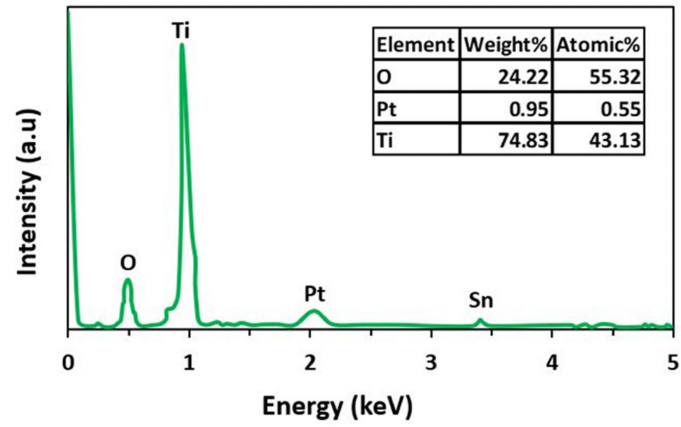
Figure 6. EDS spectra of nanocomposite